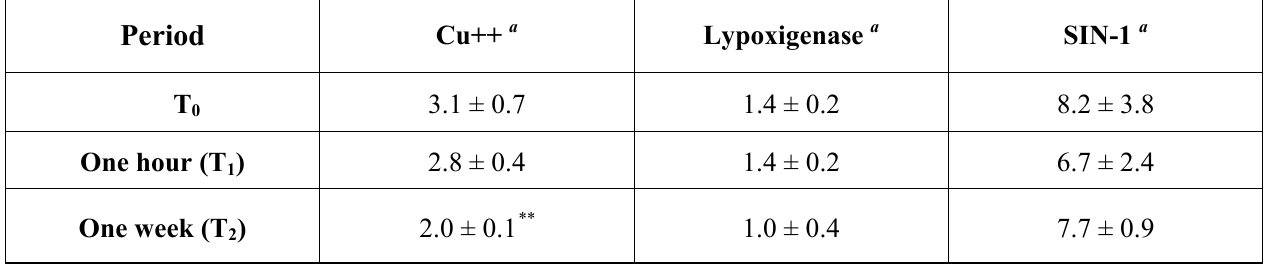
Table 4. LDL maximal rate of conjugated diene formation ( Δ abs/ Δ time) after oxidation induced ex vivo , at the baseline (T ) and after acute (one hour –T 0 week –T ) ingestion of instant maté tea employing three different oxidation 2